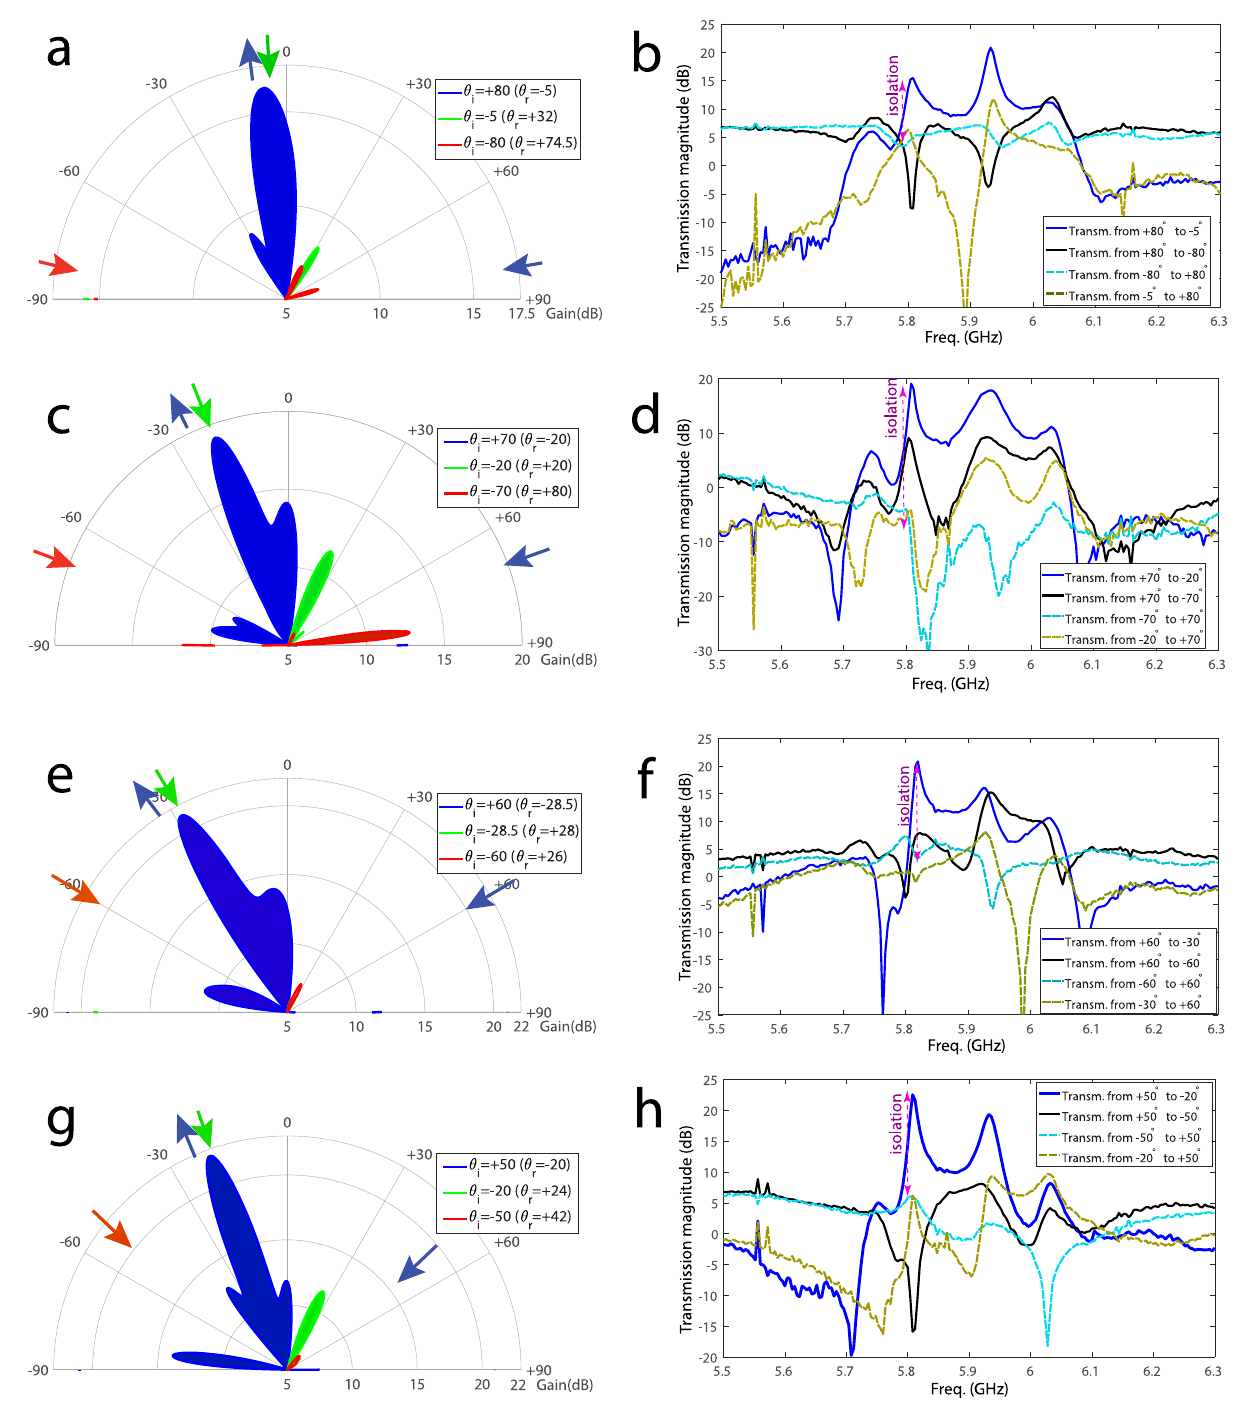
Fig. 7 Experimental results for full-duplex re fl ective beamsteering. The angular and frequency responses are measured for wave incidence upon different angles of incidence. Polar plots are measured at 5.81 GHz. a , b θ i = 80°. c , d θ i = 70°. e , f θ i = 60°. g , h θ i =